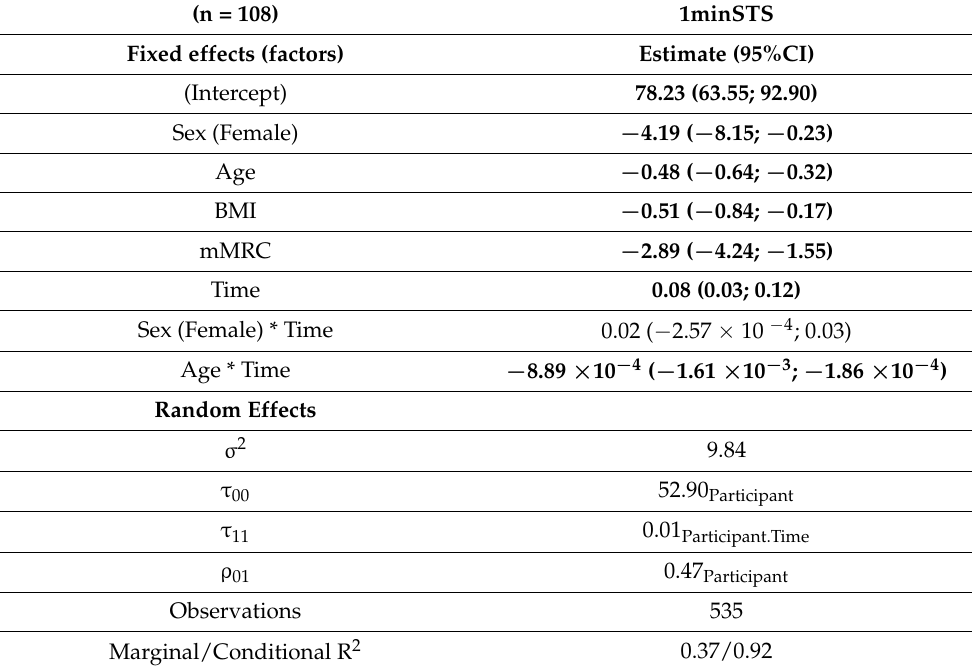
Table 2. Factors associated with the number of repetitions in the one-minute sit-to-stand test (1minSTS) in people with chronic obstructive pulmonary disease (COPD) over the 6-month period (n = 108). (n =